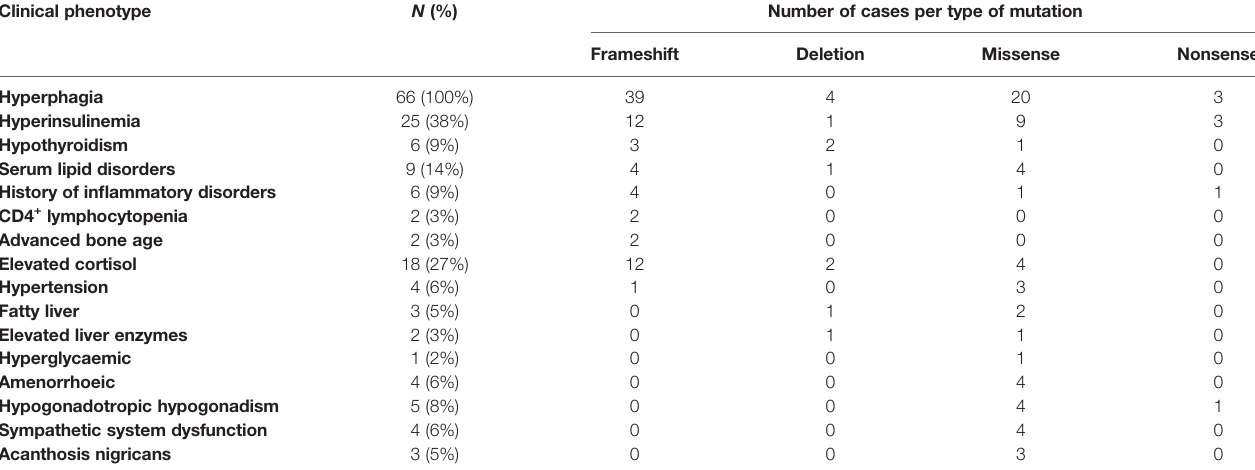
TABLE 1 | Prevalence of the clinical phenotypes of the cases. Clinical phenotype